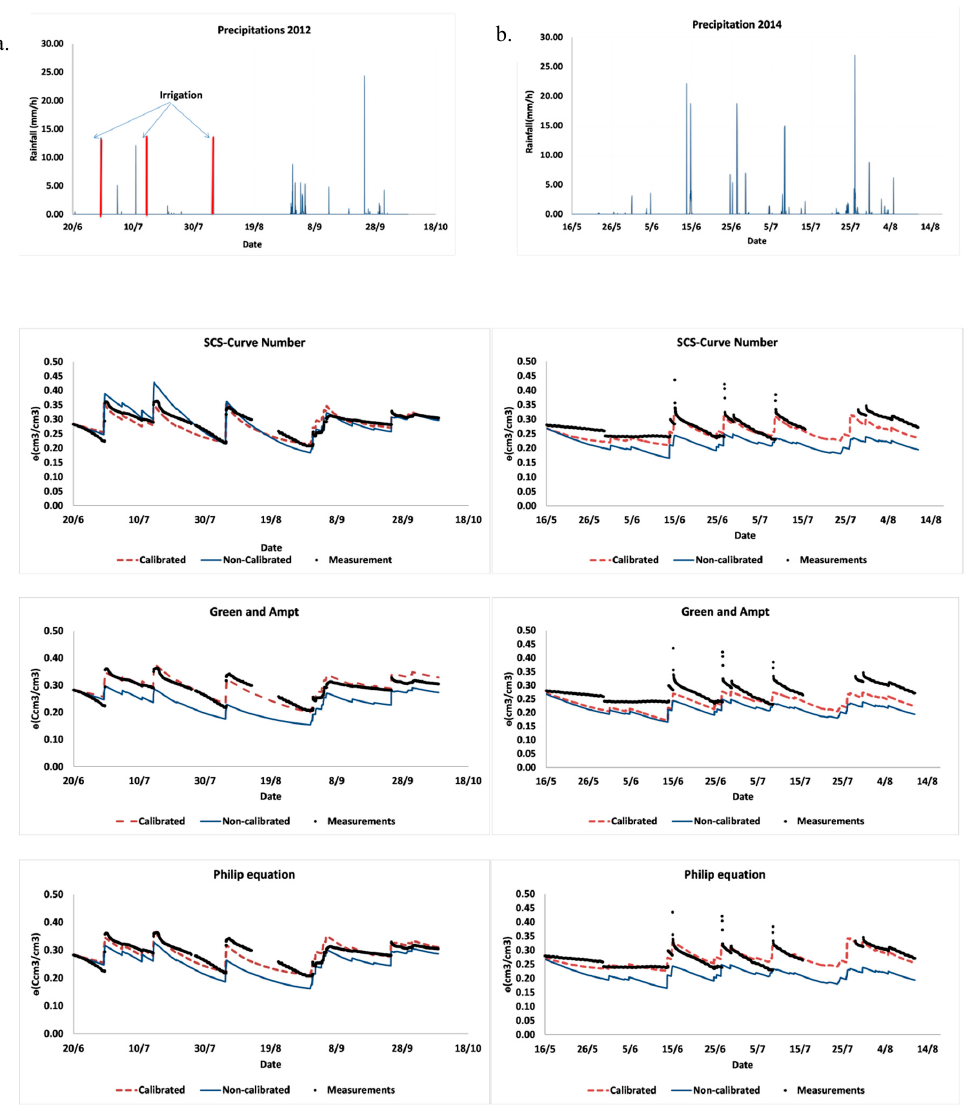
Figure 2 . ( a ) Results of calibration (2012 year) and ( b ) validation (2014 year) of Curve number, Green and Ampt and Philip equations based soil moisture simulations.